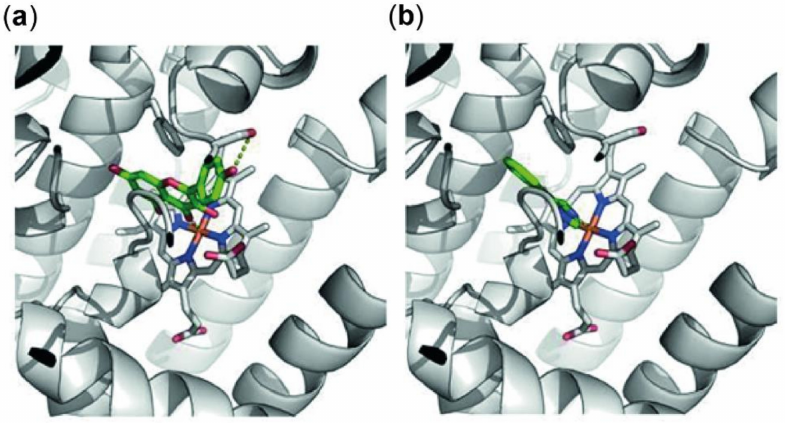
Figure 5. Predicted protein ligand interactions of kaempferol with indoleamine 2,3-dioxygenase 1 (IDO-1) ( a ) and within the crystal structure of 4-phenylimidazole and IDO-1 ( b ). IDO-1 is shown as grey cartoons, the heme group is highlighted with sticks. Ligand molecules are shown in green with polar intermolecular contacts highlighted with yellow dots. Both ligands occupy a similar position in the binding site, both coordinating to the iron of the heme group and stacking to phenylalanine (Phe)-163. Kaempferol shows an additional hydrogen bond to Serine (Ser)-235 not possible in 4-phenylimidazole due to the lack of polar groups.